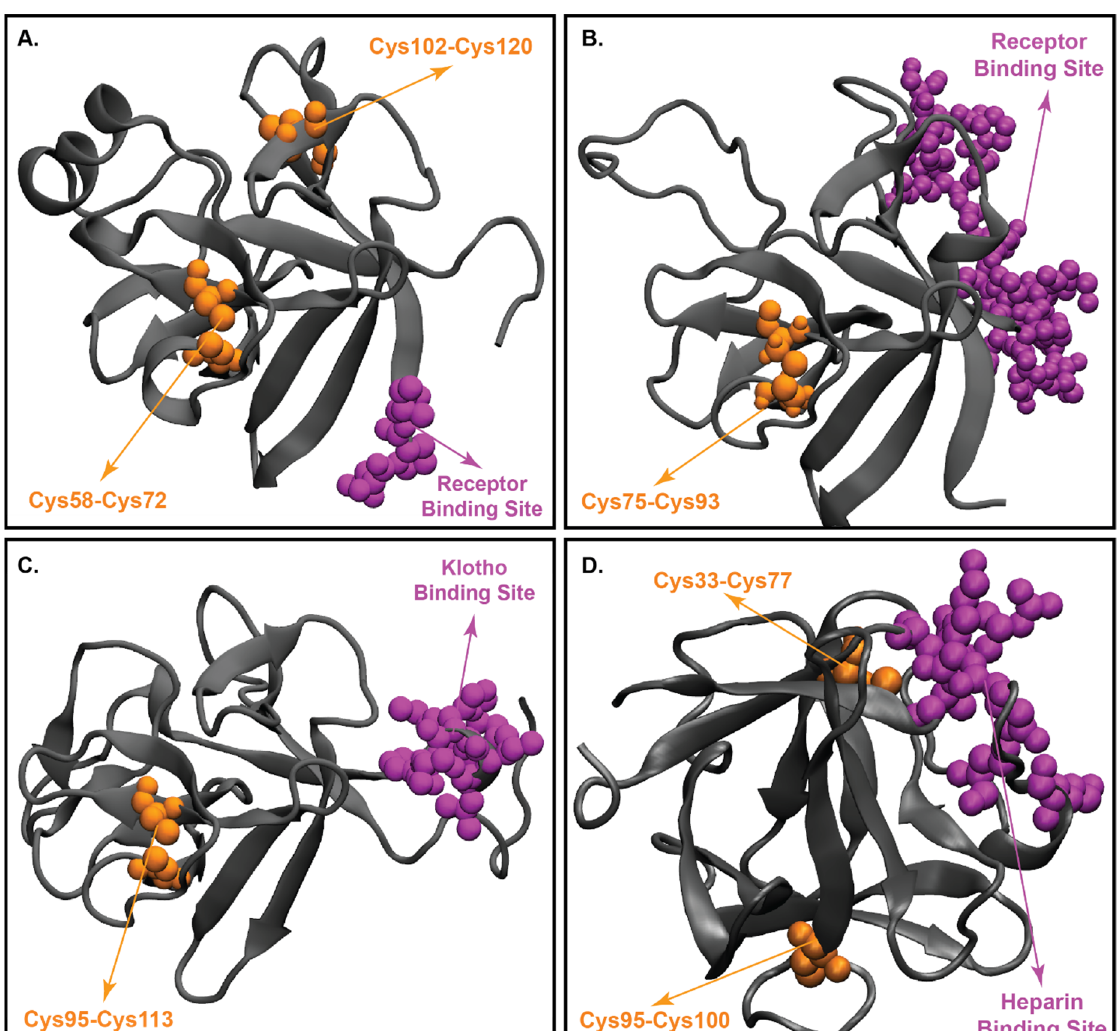
Figure 4. Crystal structures of endocrine FGFs. Panel- A : Crystal structure of FGF19. Panel- B : the crystal structure of FGF21. Panel- C : the crystal structure of FGF23. Panel- D : the crystal structure of paracrine FGF2. The protein backbone is represented as a grey cartoon, Disulfide bonds are shown as yellow spheres and receptor binding sequence is represented in magenta; All the crystal structures were prepared using visual molecular dynamics (VMD) software [176] .